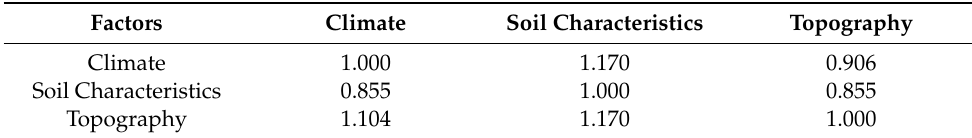
Table 4. AHP pairwise comparison matrix for the main factors.